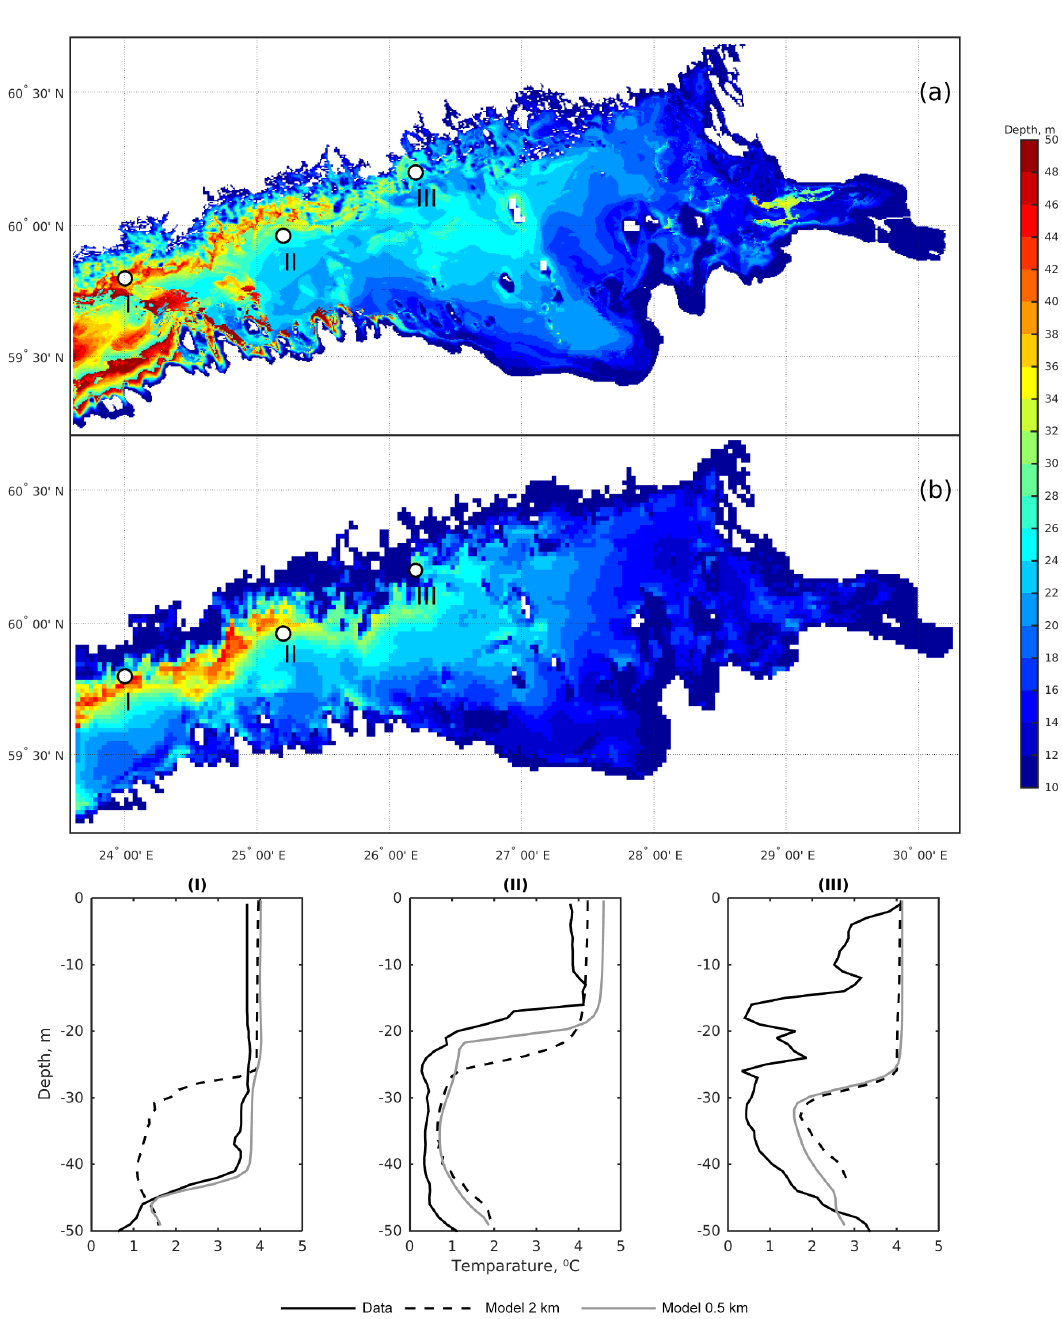
Figure 6. Modelled turbocline depth (m) in the GOF on 20 May 2011: (a) and (b) horizontal distributions on grids 0.5 and 2km respectively; (I), (II), and (III) – vertical profiles of temperature at the locations marked on maps (a) and (b) .